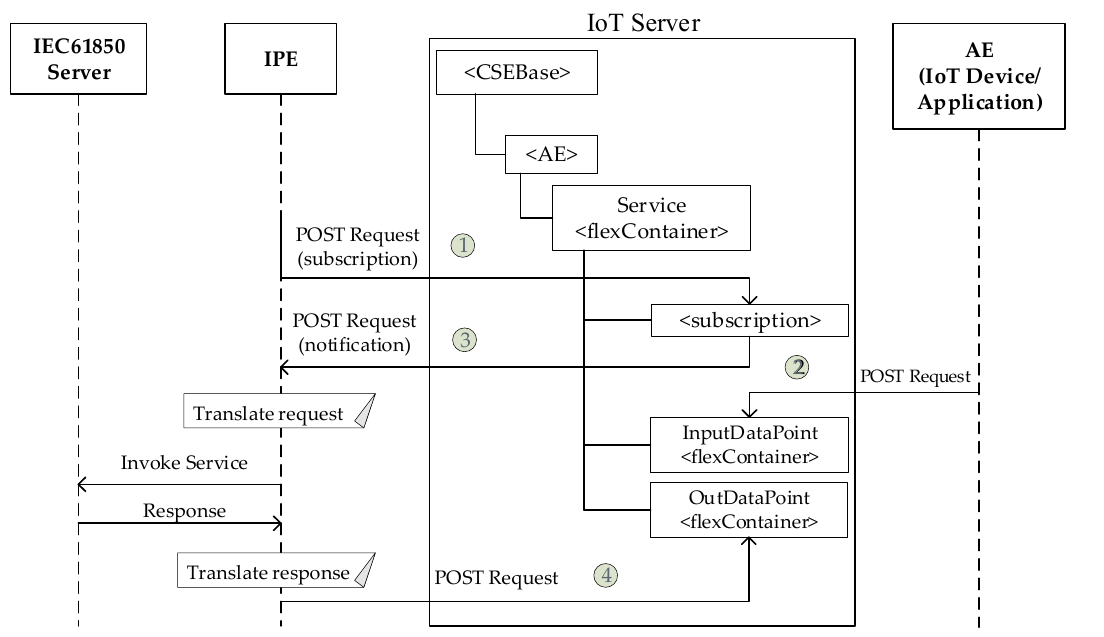
Figure 19. Invoking services running on IEC 61850 Services from oneM2M domain.